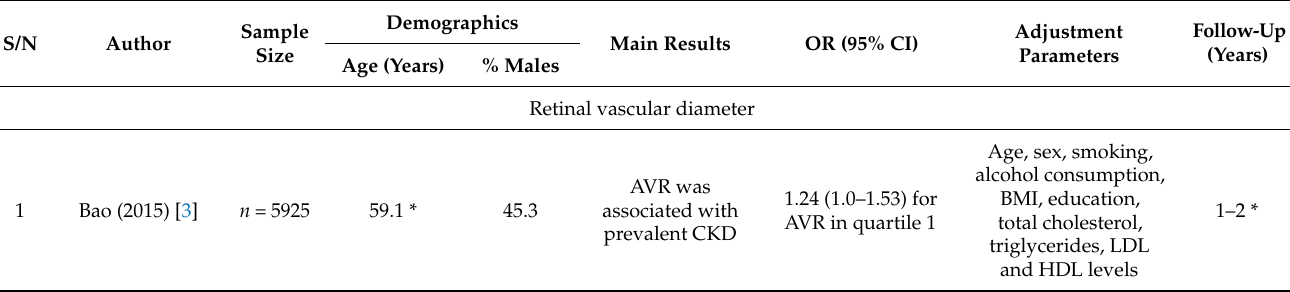
Table 3. Retinal microvascular signs and prevalent